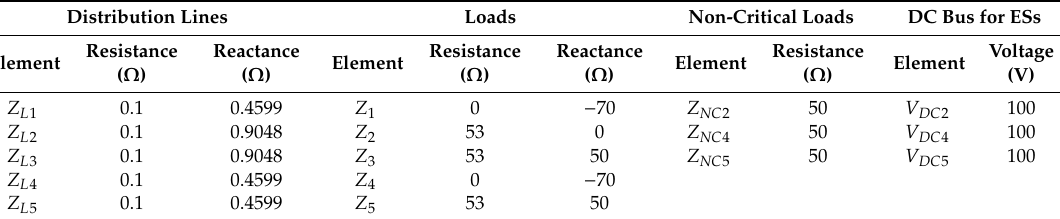
Table 2. Gains of the PI controllers and phase-locked loops (PLLs).